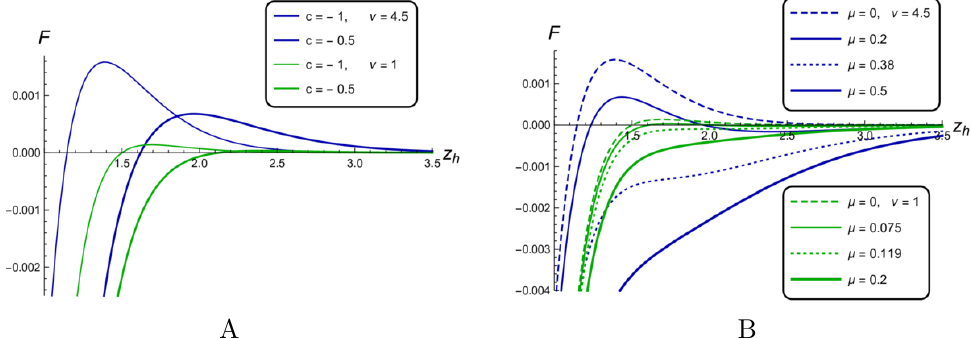
Figure 26 . The black hole free energy F ( z h ) in isotropic (green lines) and anisotropic (blue lines) cases for di(cid:11)erent c , (cid:22) = 0 (A) and di(cid:11)erent (cid:22) (cid:21) 0, c = (cid:0) 1 (B). The intersections with the